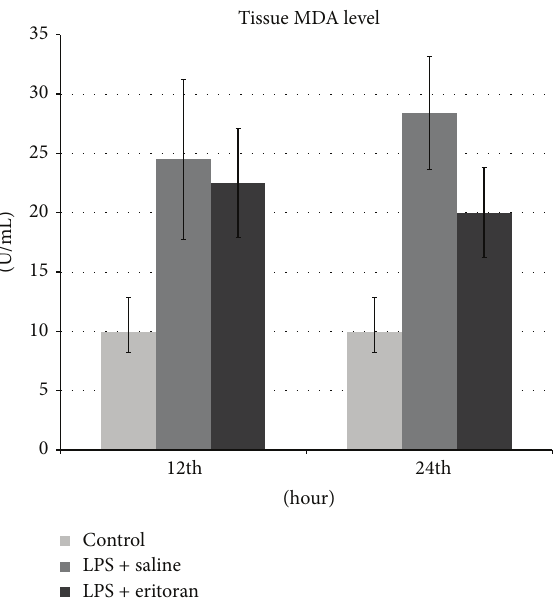
Figure 2: The tumor necrosis factor- 𝛼 (TNF- 𝛼 ) levels in retino- choroidal tissue after 12h and 24 h in control group with no intervention, rats with sepsis but without eritoran, and rats with sepsis treated with eritoran. Vertical lines show standard deviation. LPS: lipopolysaccharide.